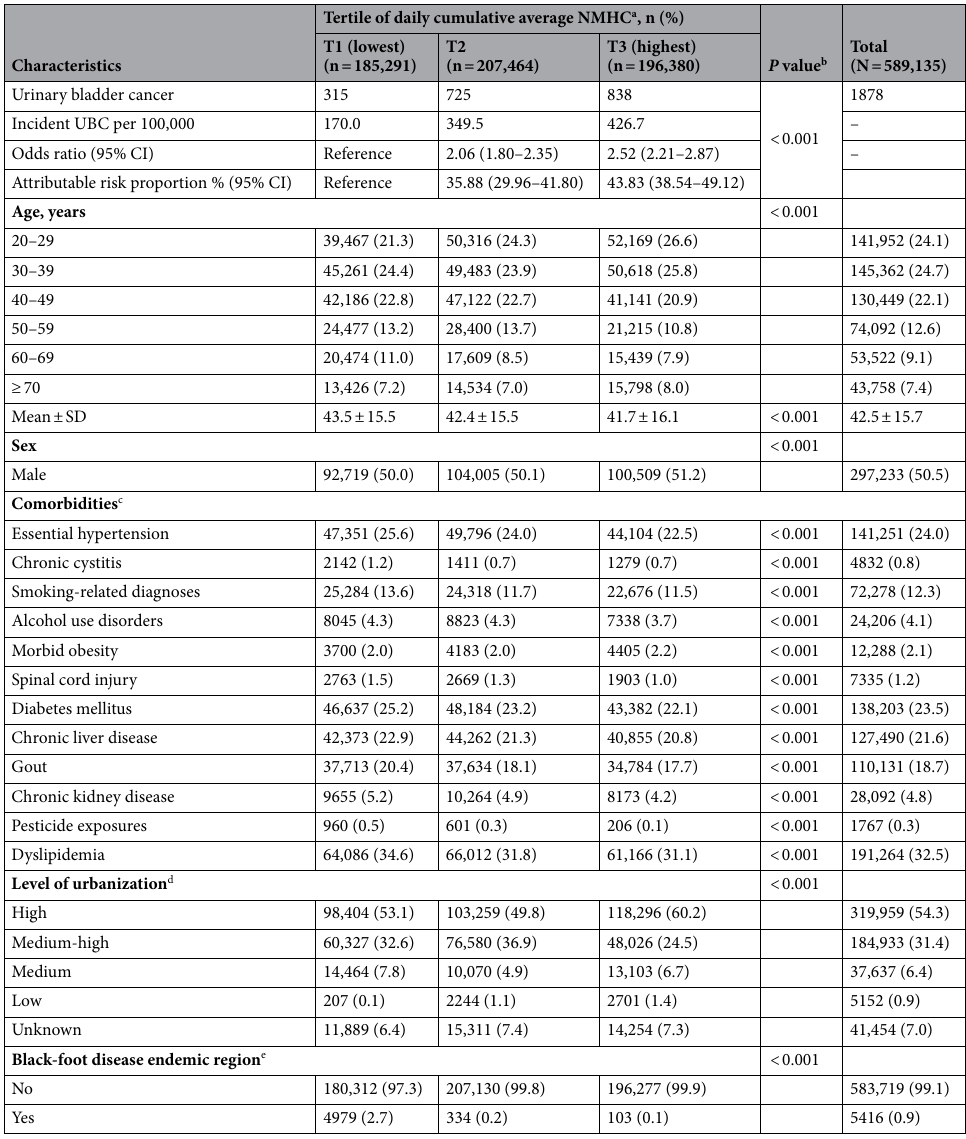
Table 2. Odds ratios of incident urinary bladder cancer by each tertile of nonmethane hydrocarbons exposure and characteristics of the cohorts. CI confidence interval, NMHC nonmethane hydrocarbon, SD standard deviation, UBC urinary bladder cancer. a The tertile values, in ppm, are as follows: T1: < 0.25, T2: ≥ 0.25 and < 0.33, and T3: ≥ 0.33. b The Chi-squared test or one-way analysis of variance among tertiles of nonmethane hydrocarbons. c Comorbidities were before the survival date. d Level of urbanization was defined at the beginning of the follow-up period. e The historic black-foot endemic region included six southwestern coastal townships where people drank arsenic-contaminated well water before tap water installation in